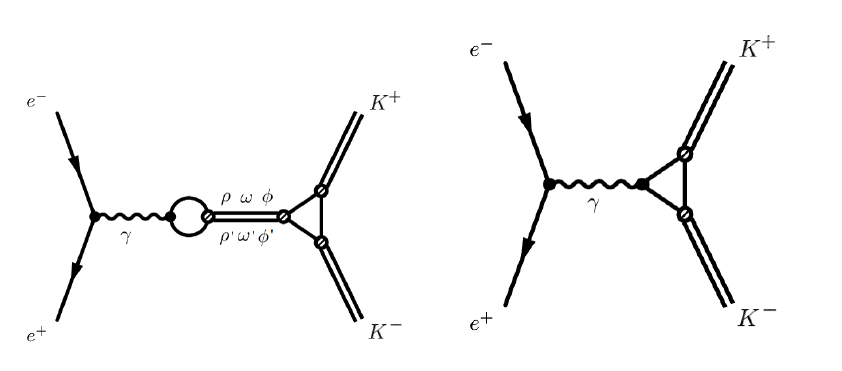
Figure 1. Amplitudes with (left) and without (right) intermediate vector